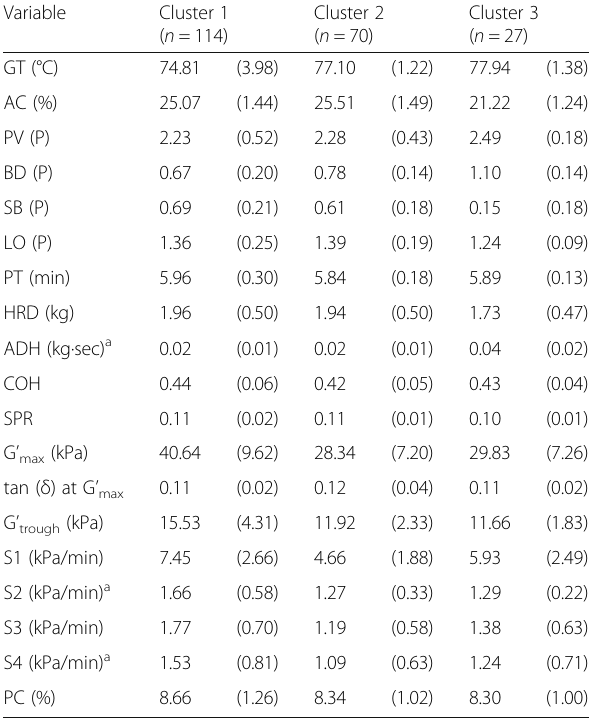
magnitude less than